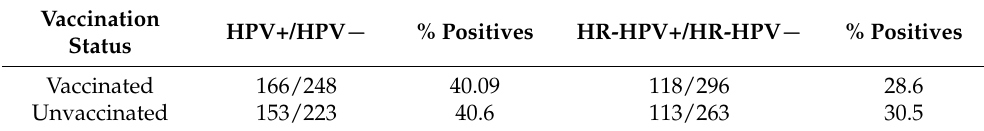
Table 2. Prevalence of HPV and high-risk HPV infection according to vaccination status.